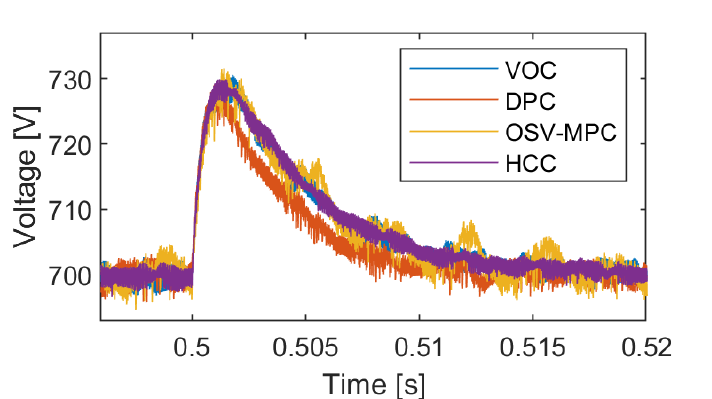
Figure 32. DC link voltage transient with sudden 20% load